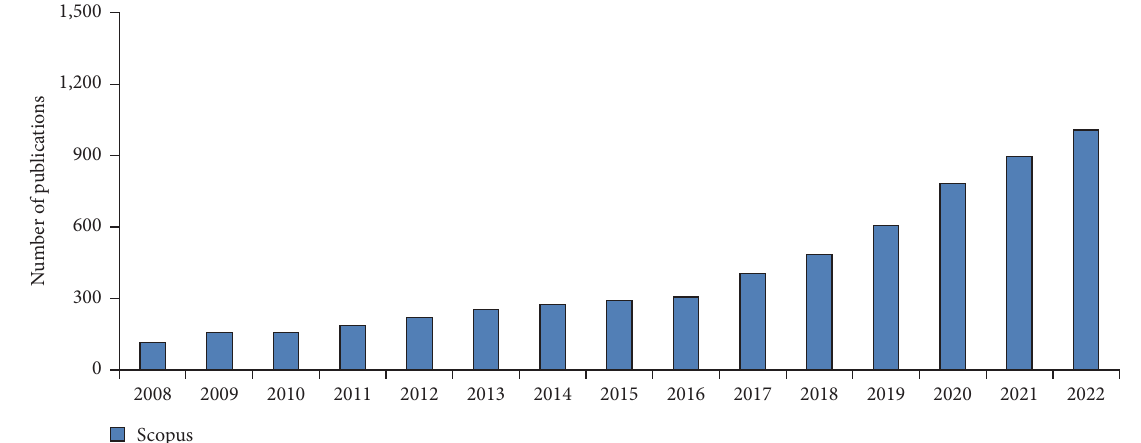
F IGURE 1: The number of publications that are based on 3D bioprinting of living tissue and was using search terms “ 3D bioprinting and tissue engineering. ” Data analysis was searched Scopus database on November